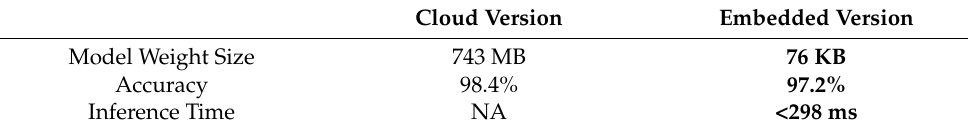
Table 4. Original vs. Compressed Deep Learning: Model Weight Size, Accuracy and Inference Time.